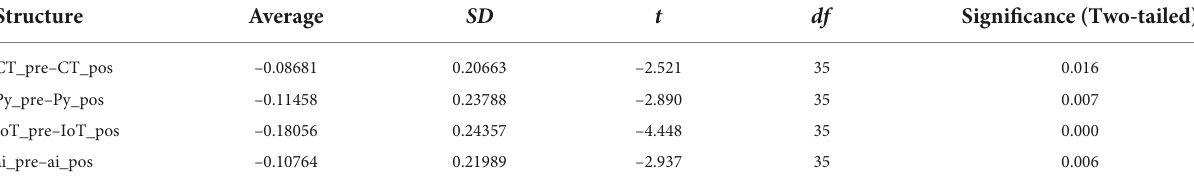
TABLE 8 The verification and analysis of Students’ AIoT Knowledge of Information Technology on sample t -test.